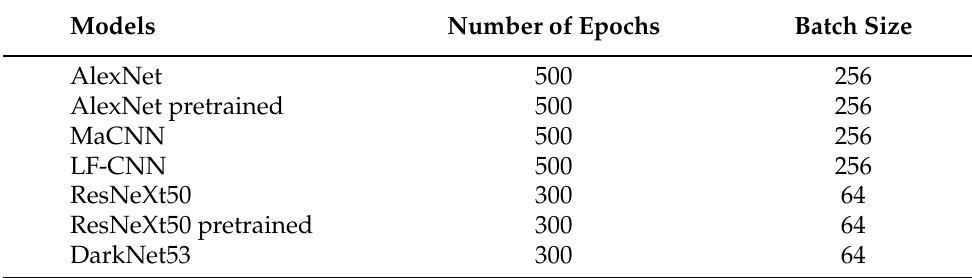
Table 2. Configurations of the